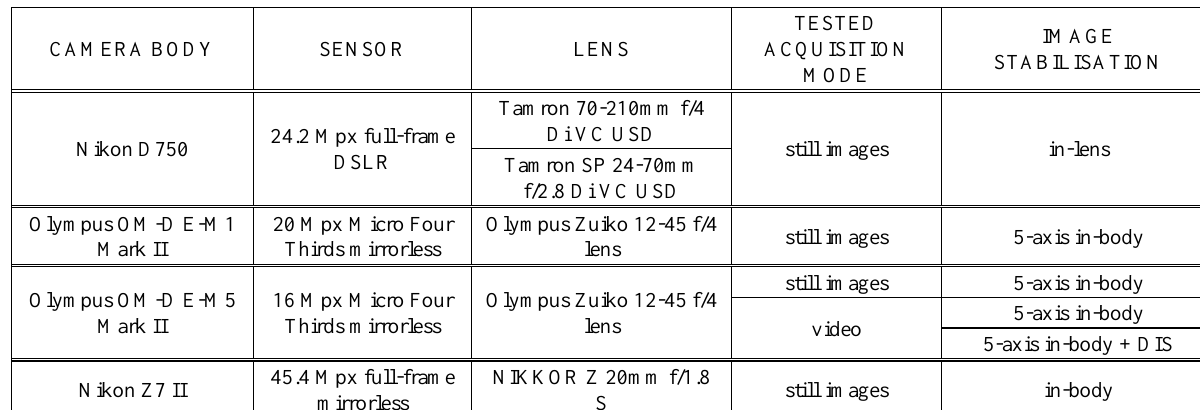
Table 1 . Imaging systems